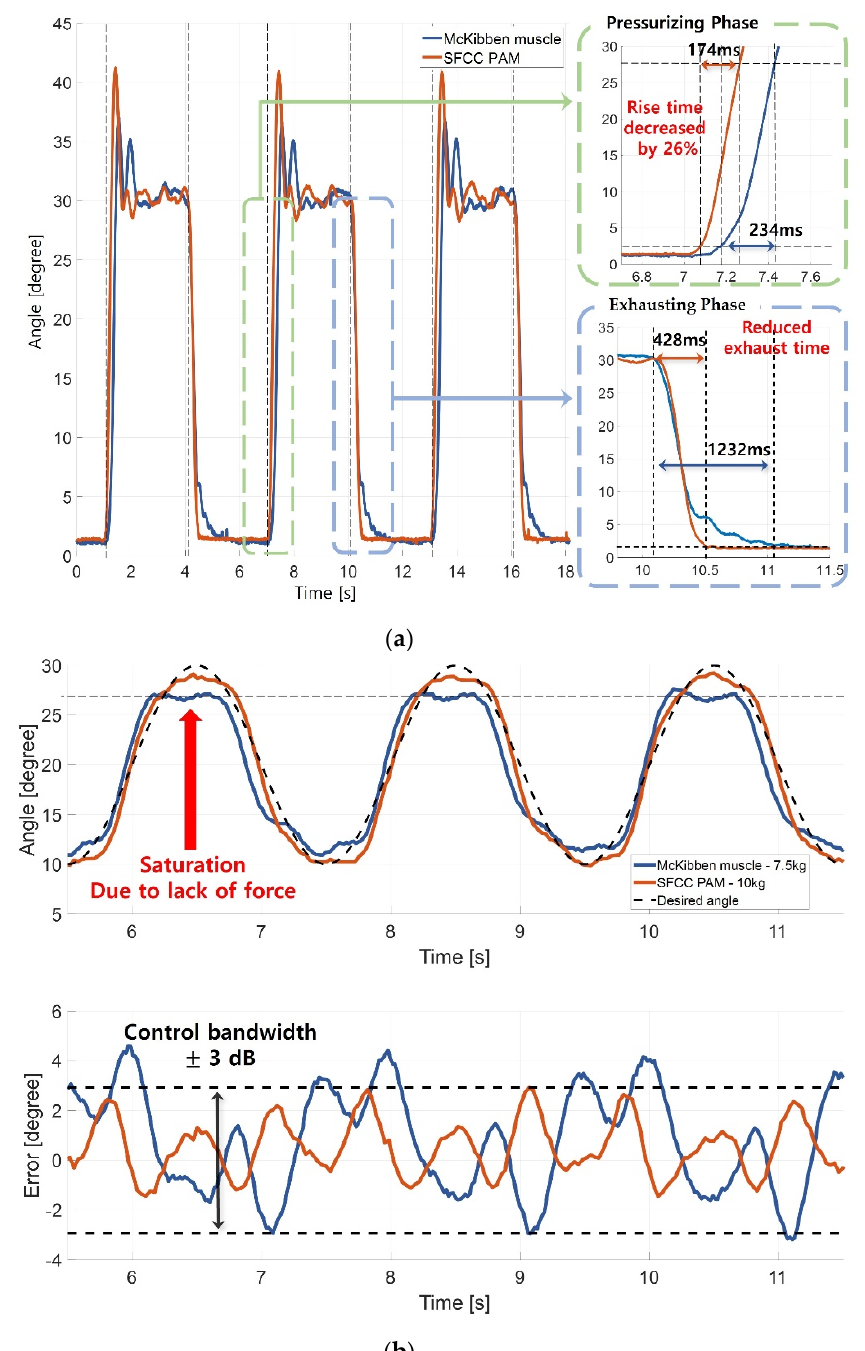
Figure 7. ( a ) Comparing the rise time of two actuators with 30 ◦ ramp input. ( b ) The tracking performance of SFCCM PAM with sinusoidal input.